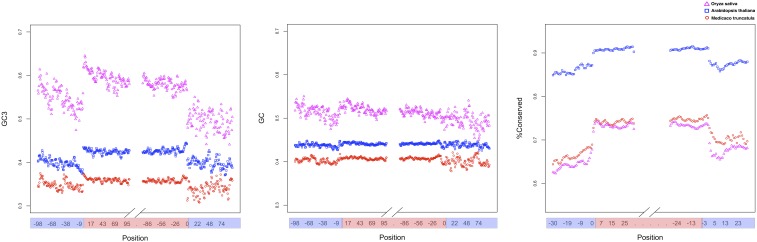
Average GC3, average GC, and percentage of conserved sites within different portions of the transcripts in A. thaliana, M. truncatula, and O. sativa. Position axes refer to the number of sliding windows analyzed (window step = 3 nt/1 amino acid; window size = 9 nt/3 amino acids). Average GC3 and GC values are calculated at a nucleotide level, whereas the percentage of conserved sites refers to the protein coordinates. Red represents the domain regions and blue represents the nondomain regions.